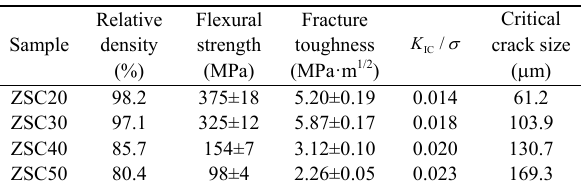
Table 2 Relative densities, mechanical properties, and calculated critical crack sizes of ZrB 2 –SiC–C f composites, showing high relative densities